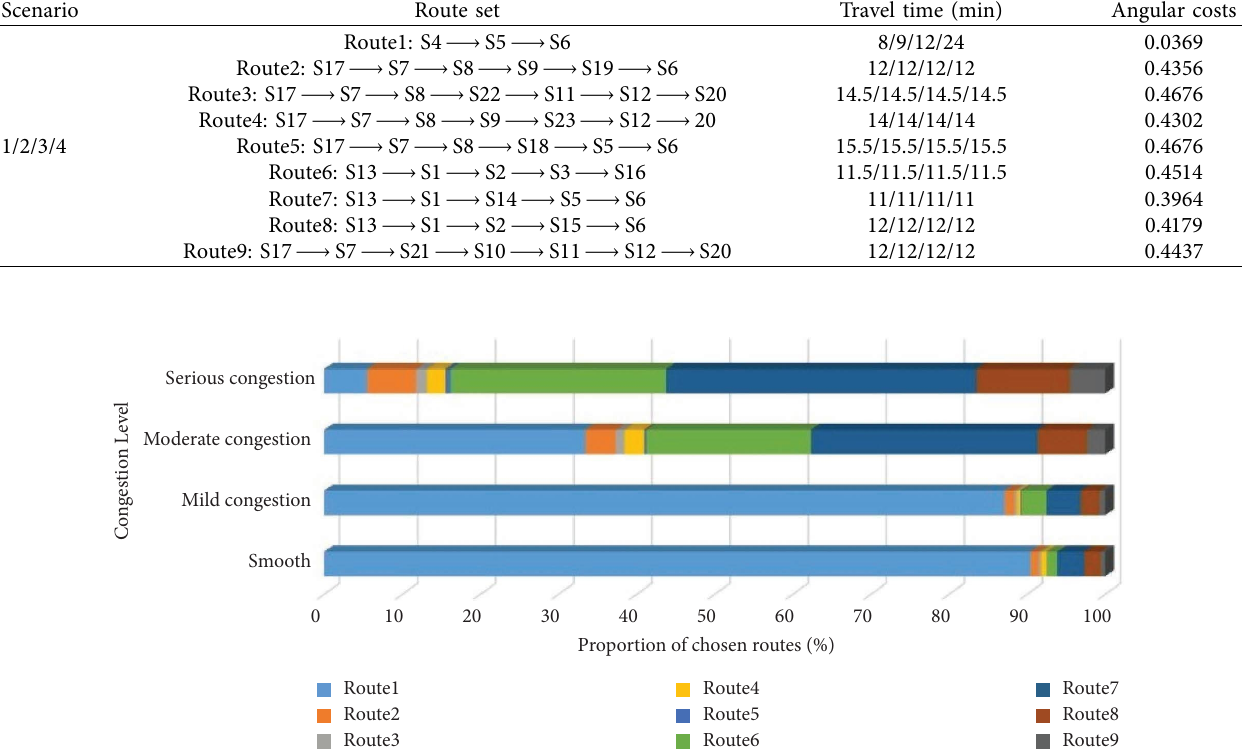
Table 2: Attribute levels of travel routes in four scenarios.